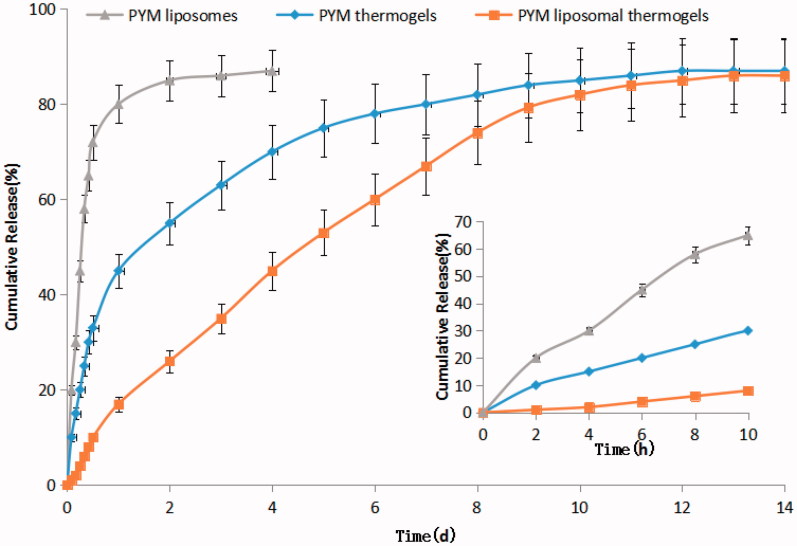
PYM in vitro release profile from PYM liposomes, PYM thermogels and PYM liposomal thermogels (n = 3).